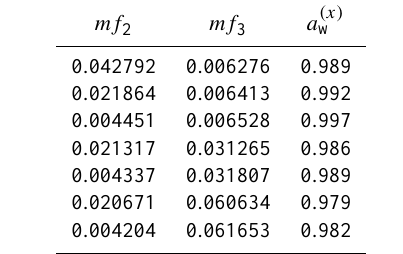
Table A2. Bulk water activity measurements of the system water